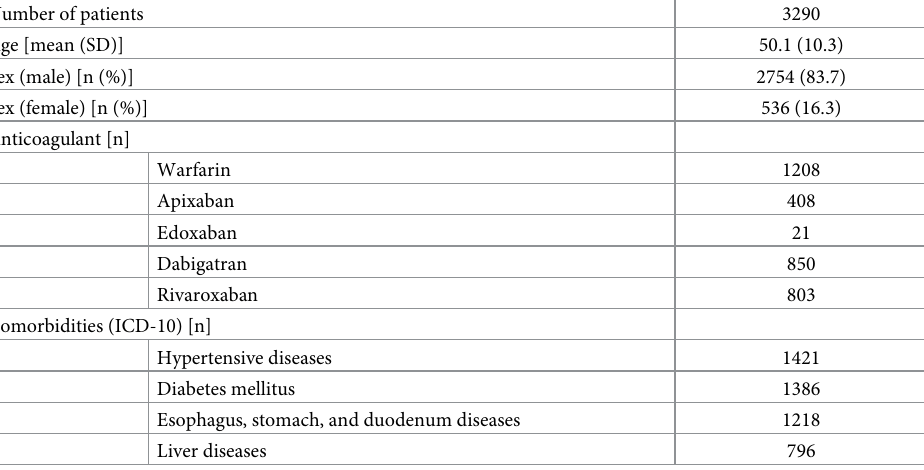
Table 1. Characteristics of patients with atrial fibrillation (from the claims